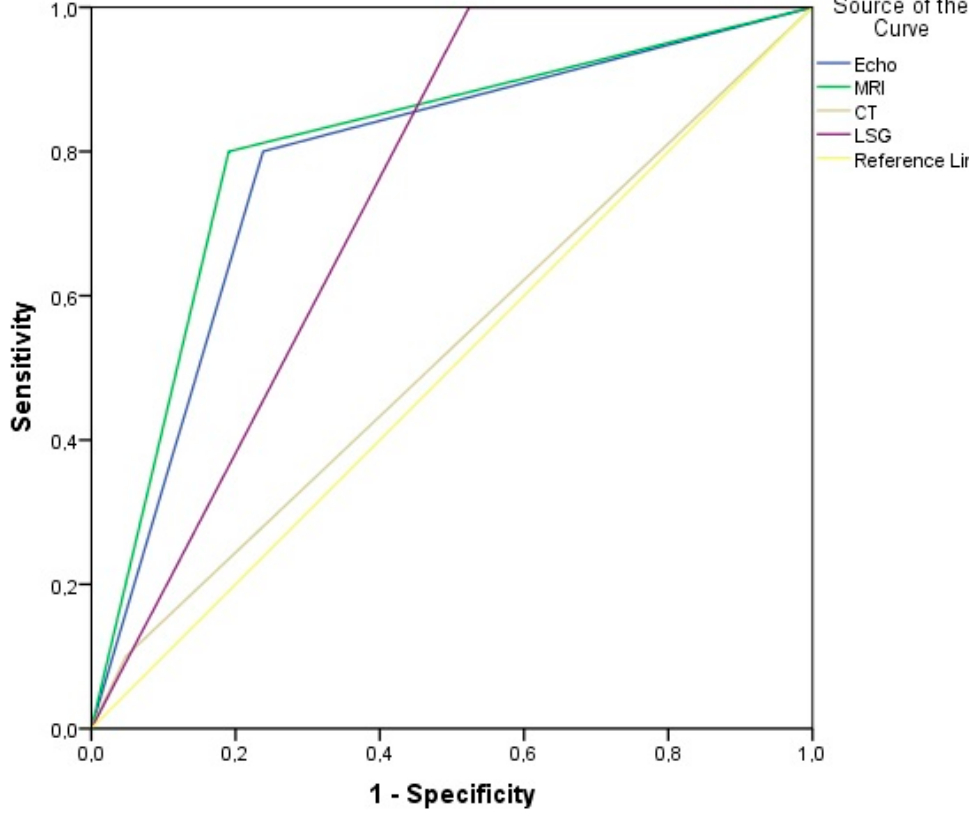
Figure 2. The ROC curve analysis to predict lymph node enlargement with four different diagnostic tools (echo-ultrasound, MRI, CT and LSG).